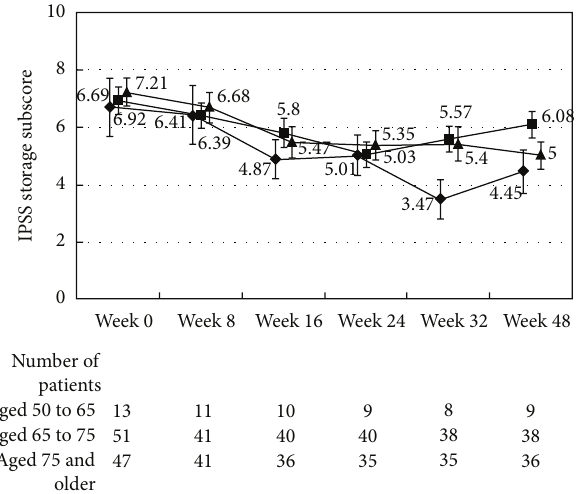
Figure 9: International Prostate Symptom Score storage subscore by age. The scores in the patients aged from 50 to 65 ( ⧫ ), the patients aged from 65 to 75 ( ◼ ), and the patients aged 75 and older ( 󳵳 ) are shown. The values are LS mean ± SE. 𝑃 = 0.0290 (repeated ANOVA).